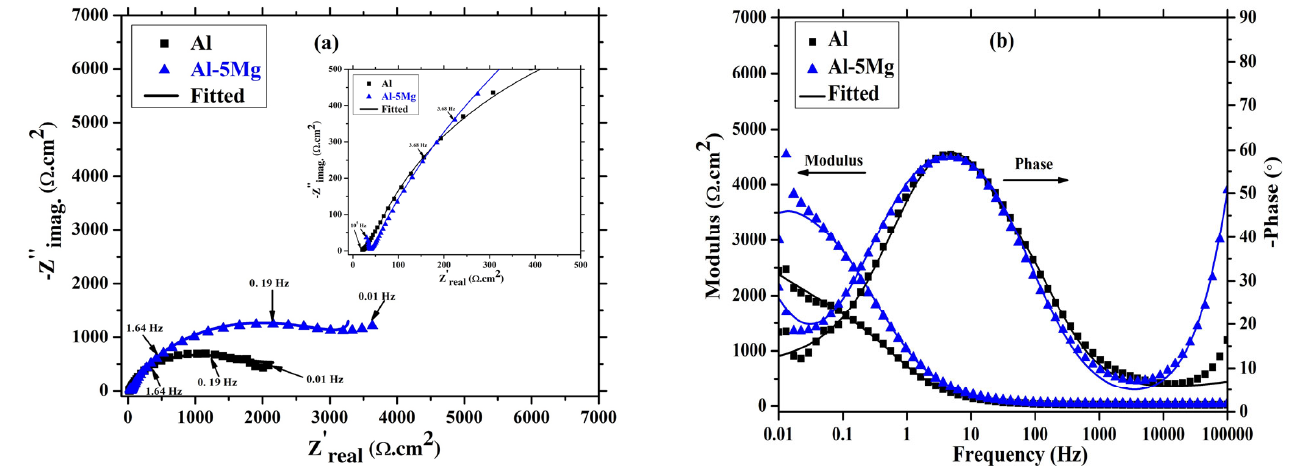
Figure 8. EIS ( a ) Nyquist and ( b ) Bode plots of coatings after 8 d of immersion in 3.5 wt.% NaCl solution. Table 2. Electrochemical parameters of the coatings.